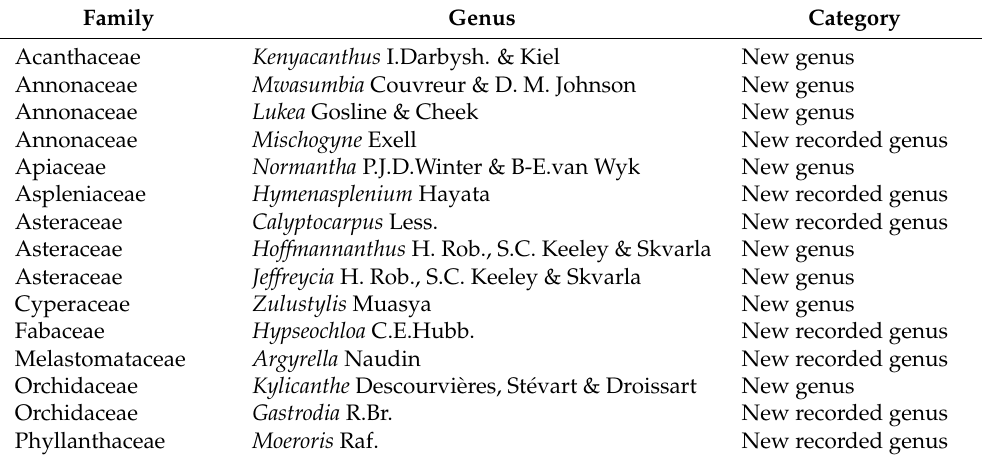
Table 1. Overview data for newly discovered and new records of vascular plants genera in tropical East Africa from 1952 to